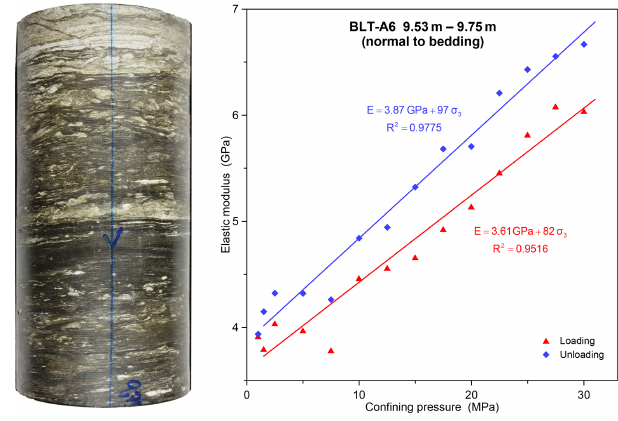
Figure 13. Sample from BLT-A6 borehole (drill depth from 9.53 to 9.75m) and dependency of elastic modulus on confining